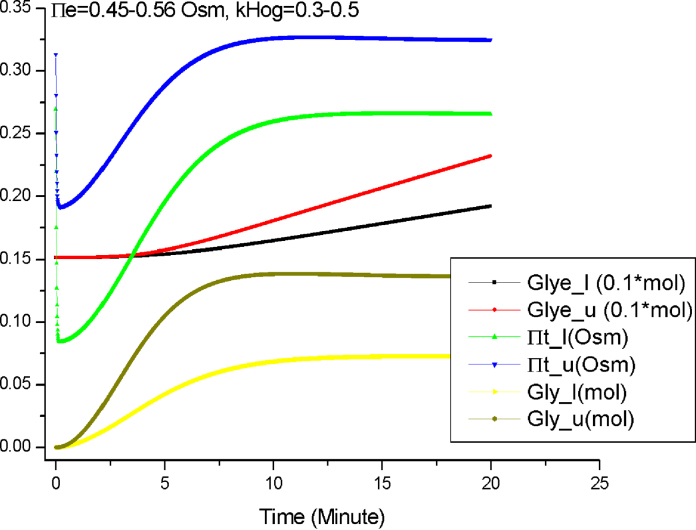
The semi-quantitative simulation by Morven when Πe = 0.45–0.56 Osm and kHOG = 0.3–0.5.